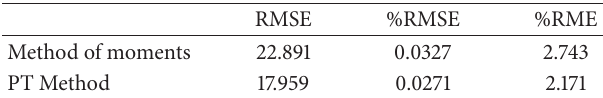
Table 1: Simulation errors.